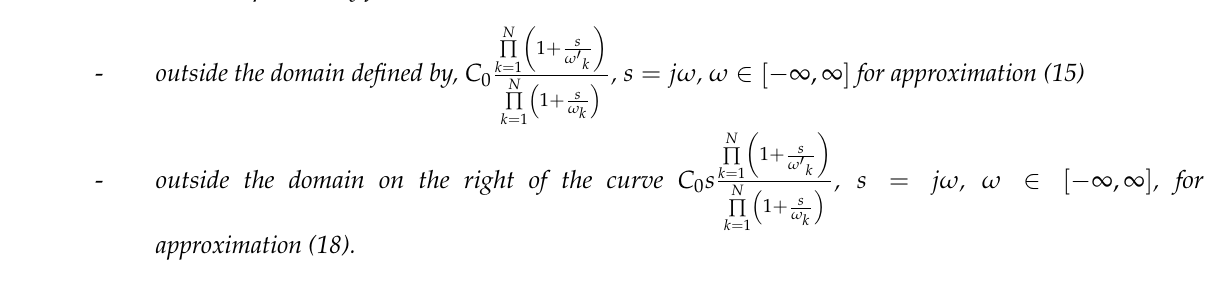
Figure 10. Image of path Г by approximations (15) and (18): definition of vector ( left ), full contour image ( right ).